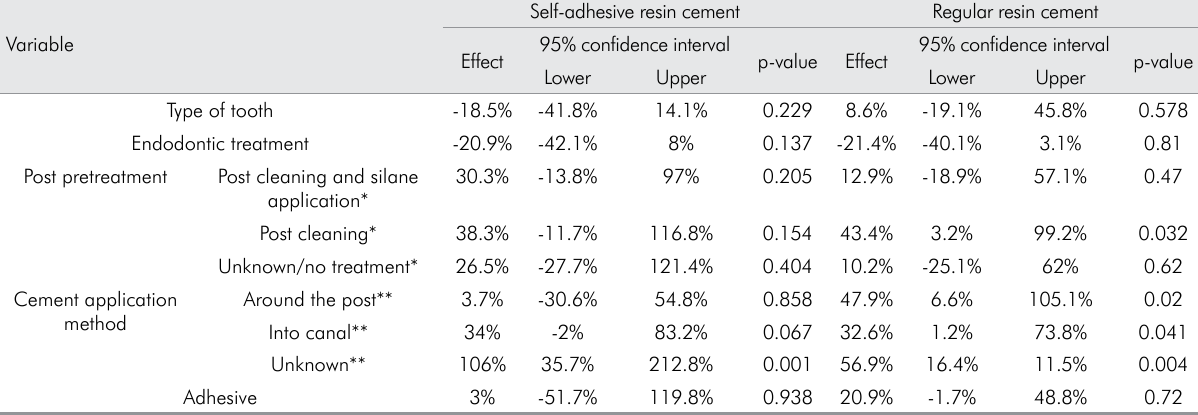
Table 3. Regression model for self-adhesive and regular resin cement. R-square = 0.309 and 0.237 respectively.